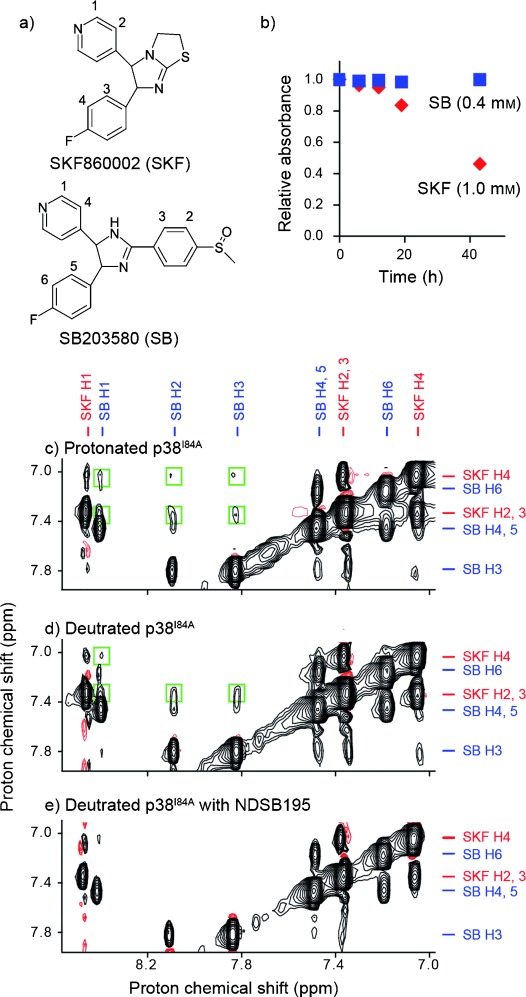
Biochemical and structural analyses of aggregation-prone SKF and soluble SB. a) Chemical structures of SKF and SB. b) Time-dependent change in the relative UV absorbance of 1.0 mm SKF and 0.4 mm SB solutions measured at λ=324 and 314 nm, respectively. c–e) INPHARMA NOESY spectra of SKF, SB, and p38αI84A mixtures. p38αI84A was protonated in c) and deuterated in d, e). In e), 100 mm NDSB195 was added to the sample. Mixing time was set to 200 ms. Interligand NOE cross-peaks are indicated by green boxes.